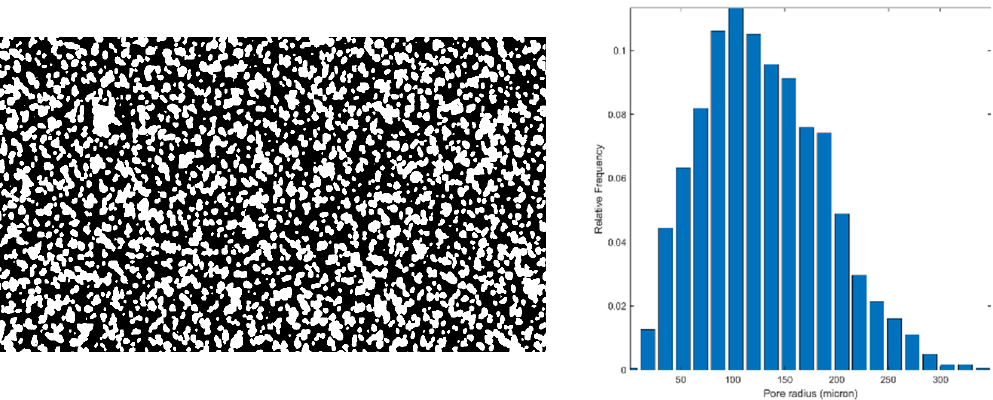
Figure 1. Left : the porous medium (20 mm × 10 mm) contained in the glass microfluidic chip (black: pore space; white: solid phase). Right : pore size distribution.